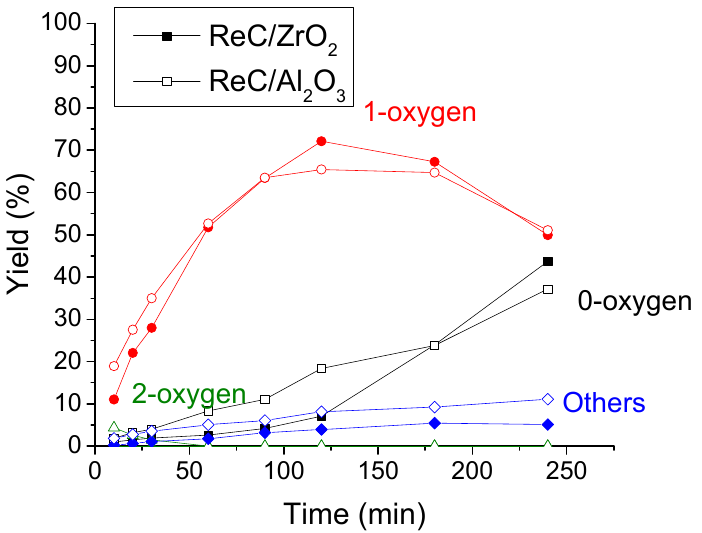
Figure 11. Evolution with time of the reactions products groups by their amount of oxygen.